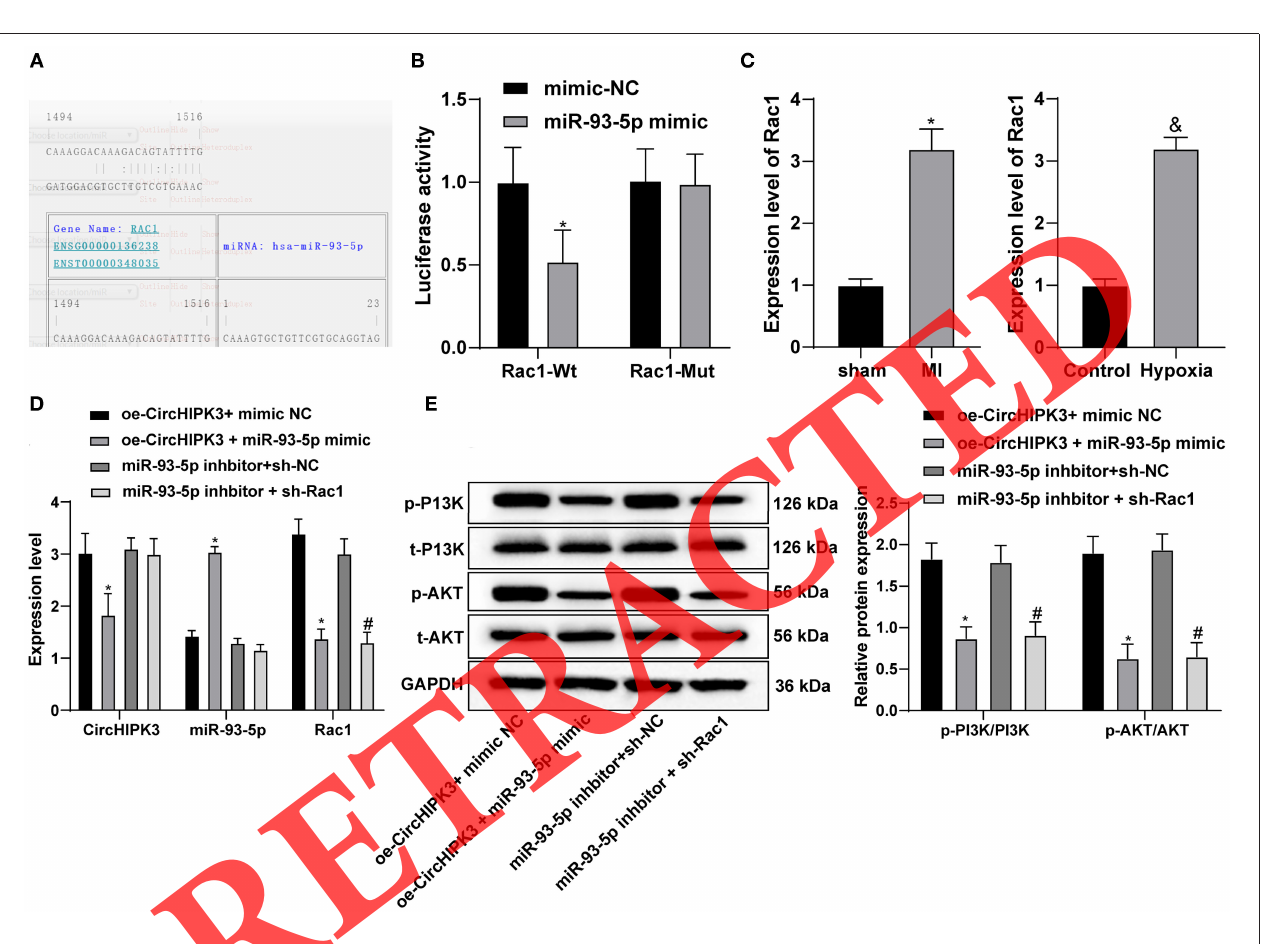
FIGURE 5 | CircHIPK3 sponges miR-93-5p to activate the Rac1/PI3K/AKT pathway. (A) The website predicted the targeting relationship between miR-93-5p and Rac1. (B) Dual-luciferase assay was used to verify the targeting relationship between miR-93-5p and Rac1. (C) RT-qPCR was used to detect the expression of Rac1 in MI model in vitro and in vivo . (D) RT-qPCR was used to detect the levels of CircHIPK3, miR-93-5p, and Rac1. (E) Western blot analysis was used to detect the protein levels of p-PI3K and p-AKT. The value in the figures is the measurement data, which is expressed as mean ± standard deviation. The comparison between two groups was analyzed by independent-sample t -test. The comparison among multiple groups was analyzed by one-way ANOVA, followed by Tukey’s multiple-comparisons test. * p < 0.05; # p < 0.05; & p < 0.05. The experiment was repeated three times.